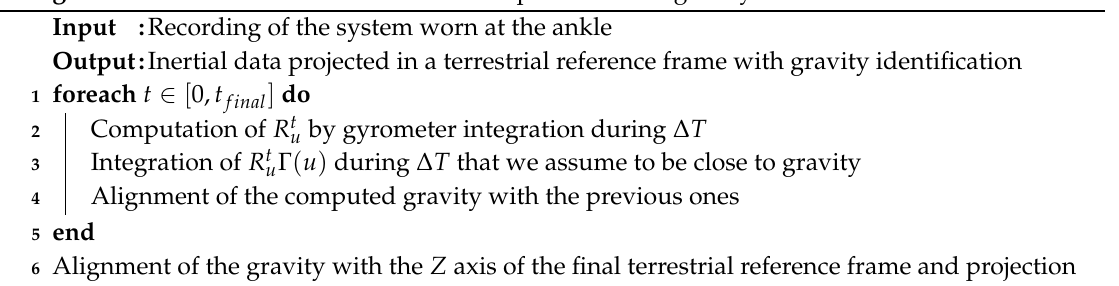
Algorithm 1: Terrestrial reference frame computation with gravity